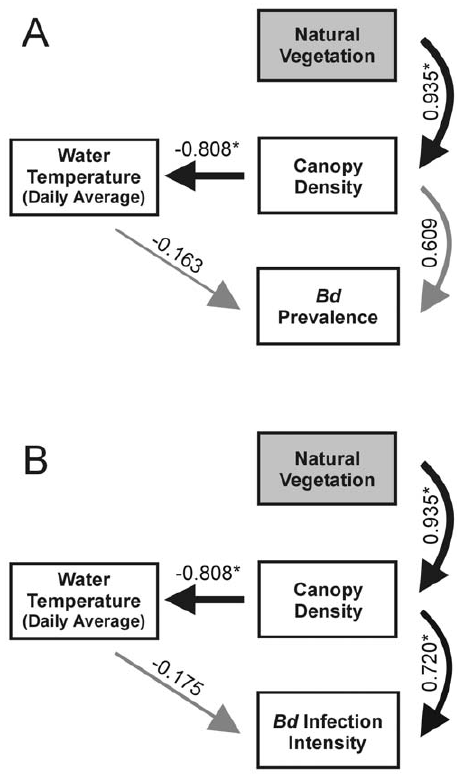
Figure 3. Alternative path models, including both direct and indirect effects of canopy density on Bd . (A) Bd prevalence; (B) Bd infection intensity. The relative strength of each effect is indicated by line width. Grey lines stand for non-significant effects. Numbers are standardized path coefficients (*P , 0.05).